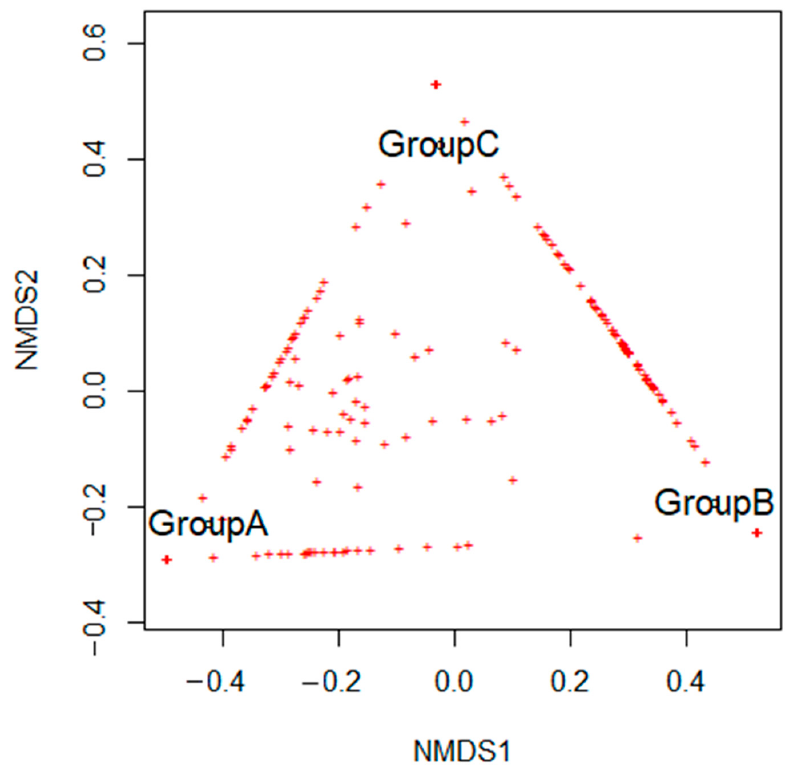
Figure 4. The non-metric multidimensional scaling (NMDS) analysis is based on the structure of Figure 4. The non ‐ metric multidimensional scaling (NMDS) analysis is based on the structure of microbial communities. microbial communities. Table 1. Alpha ‐ diversity metrics calculated for studied endolithic communities.